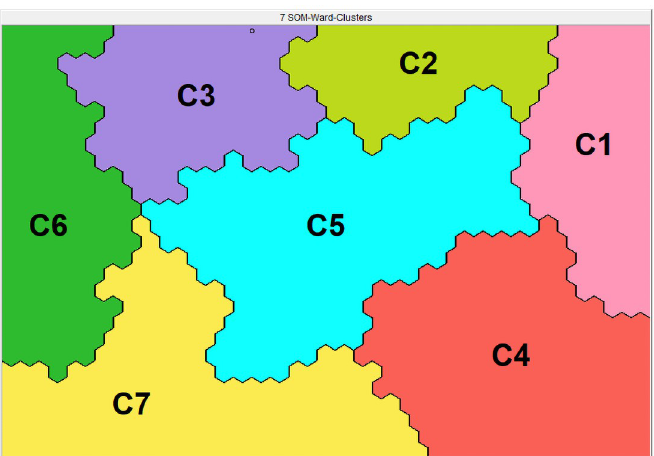
Fig 2. Seven different clusters. The Viscovery SOMine program placed all patients with COPD on a specific position on the map based on their baseline characteristics. Subjects located close to each other on the map resemble in terms of their baseline characteristics. Based on the SOM model created, seven SOM-Ward clusters with significantly different profiles have been generated: C1, ‘the overall best functioning cluster’; C2, ‘the ADL-limited cluster’; C3, ‘the multi- morbid cluster’; C4, ‘the low burden cluster’; C5, ‘the emotionally dysfunctioning cluster’; C6, ‘the overall worst functioning cluster’ and C7, ‘the physically dysfunctioning cluster’.